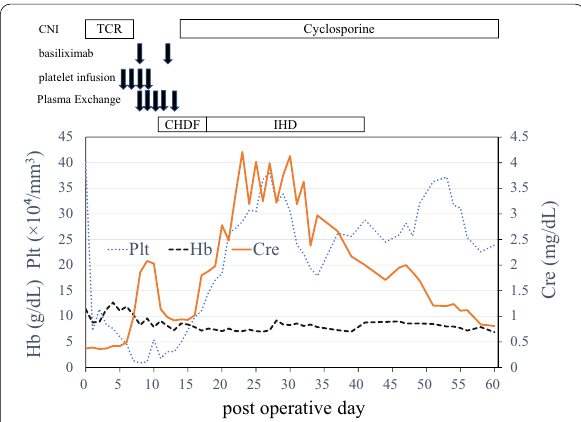
Fig. 2 Patient’s clinical course. After stopping tacrolimus and starting basiliximab, the platelet count did not worsen. The patient’s renal function gradually recovered and intermittent hemodialysis was discontinued on POD 41. The creatinine level subsequently decreased to 0.81 mg/dL on POD 60. TCR tacrolimus, CHDF continuous hemodiafiltration, IHD intermittent hemodialysis, Hb hemoglobin, Plt platelet count, Cre